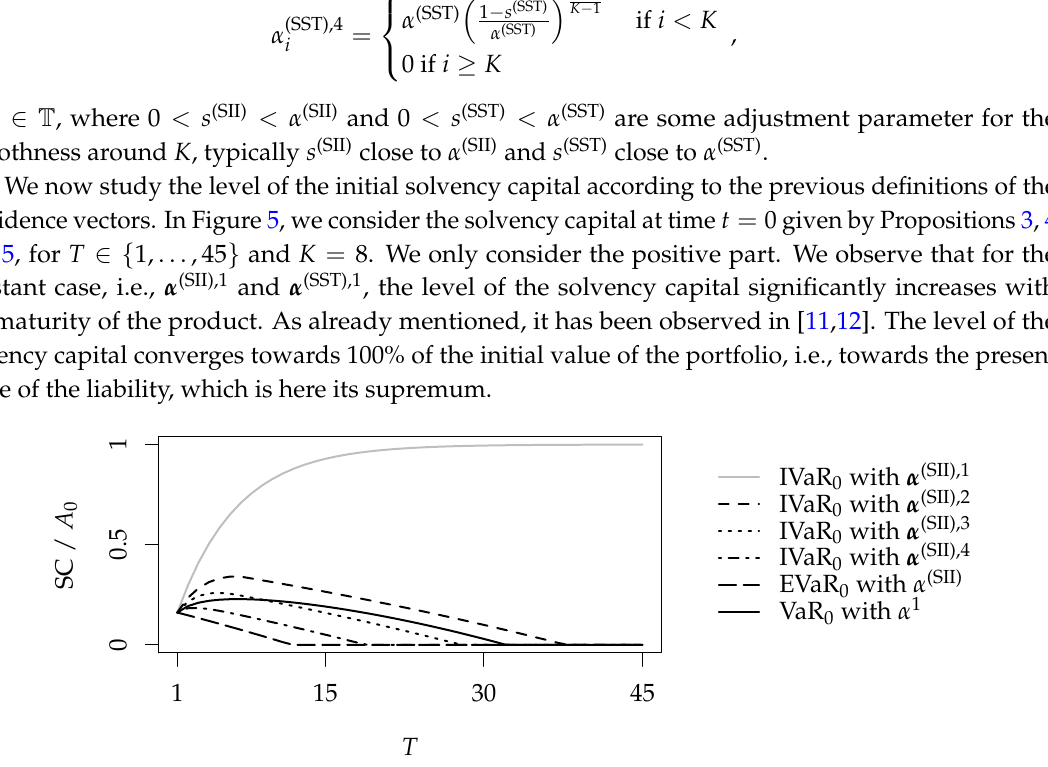
Figure 5. Computation of the solvency capital in the proportion of the initial value of the portfolio, for maturities T ∈ { 1, . . . ,45 } and a long-term threshold K =